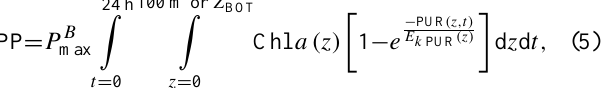
Fig. 4. Conceptual overview of an annual time series of surface Chl a (Chl a surf ) concentration throughout the growing season. The first and second temporal delimitation are defined by the highest value of surface Chl a (i.e., the paroxysm of the spring bloom) and a threshold of 9h of daylight, respectively. Modified from Wass- mann and Reigstad